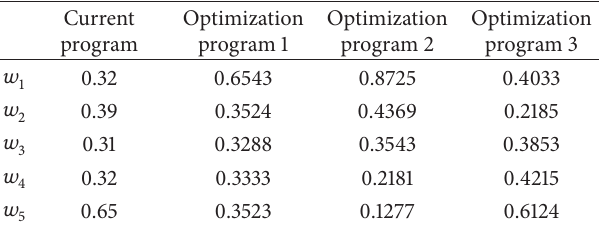
Table 6: Data of the control variables.